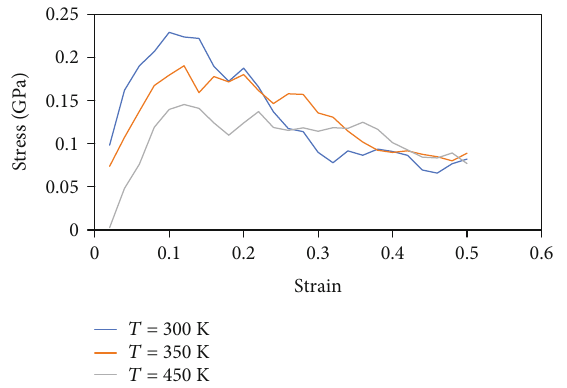
Figure 14: Tensile mechanical deformation of 6.45% porosity kerogen structure for empty and fi lled with methane cases at 6000